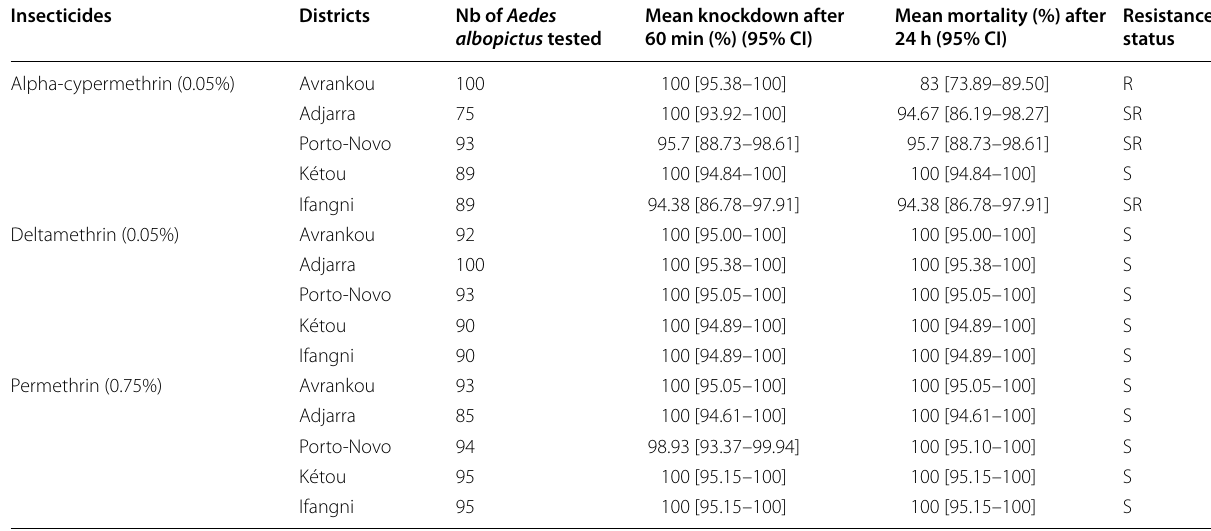
Nb number, R resistance, SR suspected resistance, S susceptibility